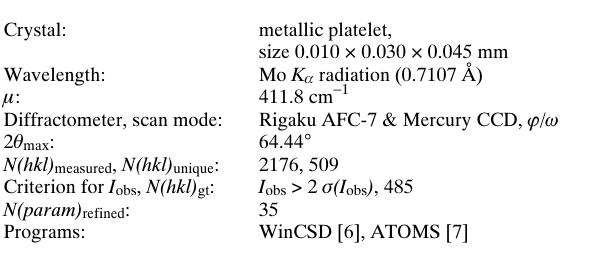
Table 1. Data collection and handling.